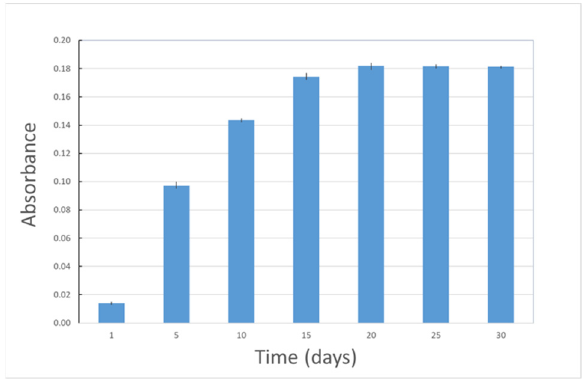
Figure 3. Time variation of absorbance in glycerine maceration.